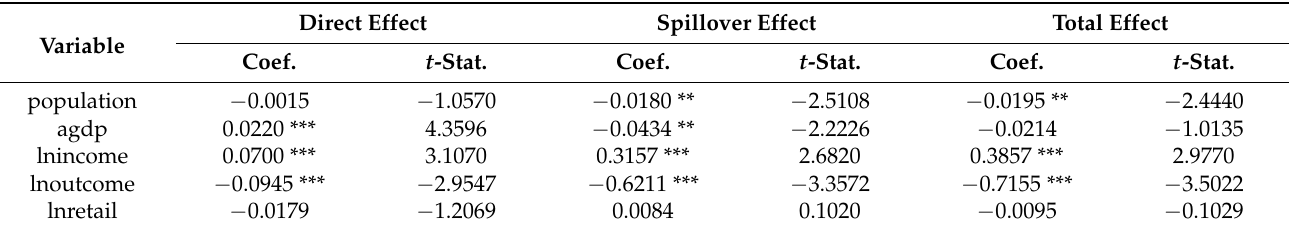
Table 6. Spatial effect decomposition results of the spatial panel Durbin